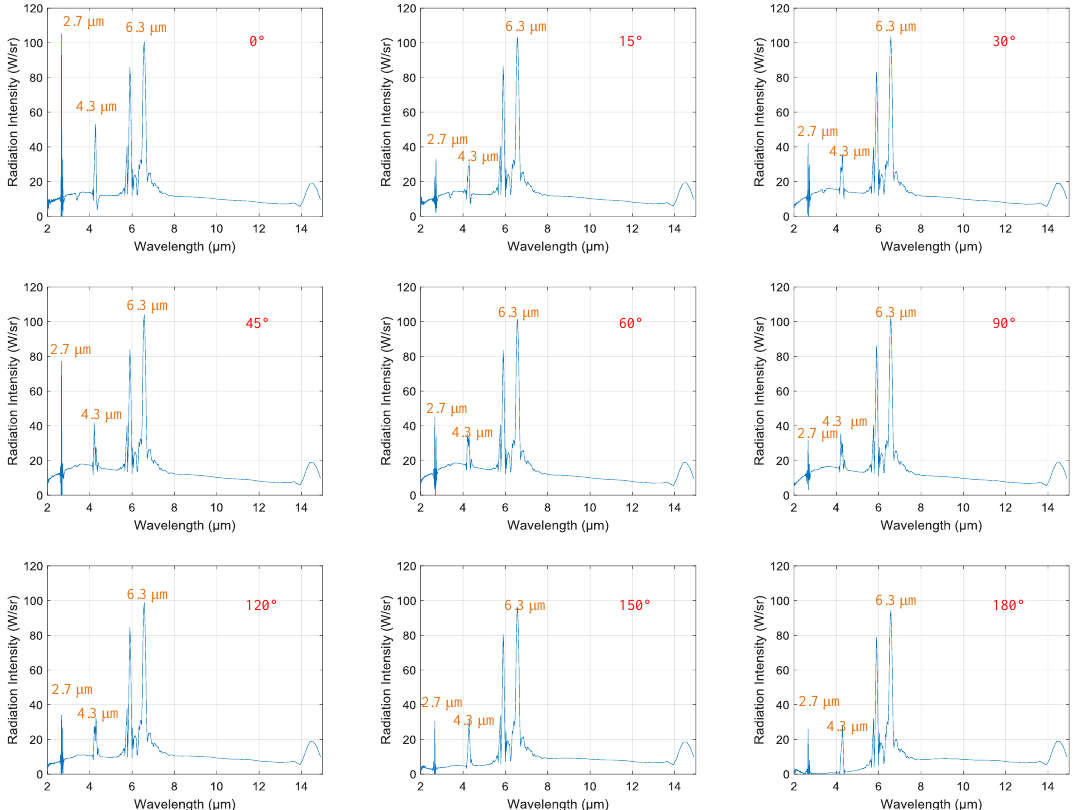
Figure 6. Spectral radiation intensity of the engine at different observation angles.